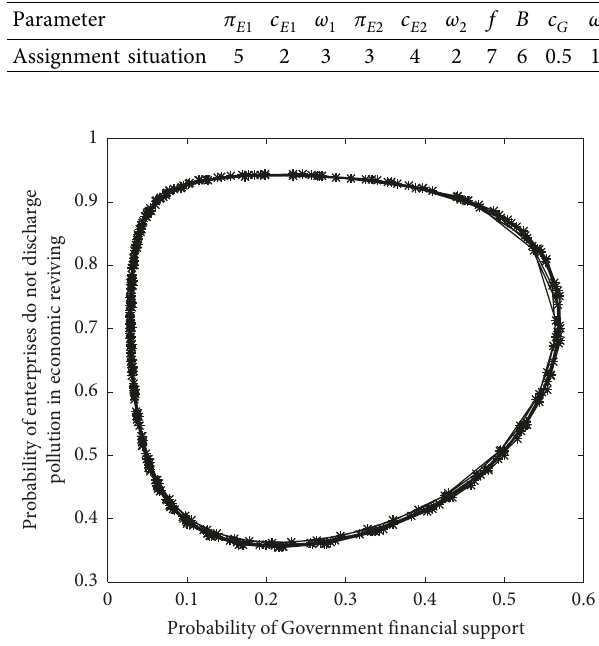
Figure 6: The evolution path when the initial probabilities of both sides of the game are the same under the static incentives mech- anism and penalties